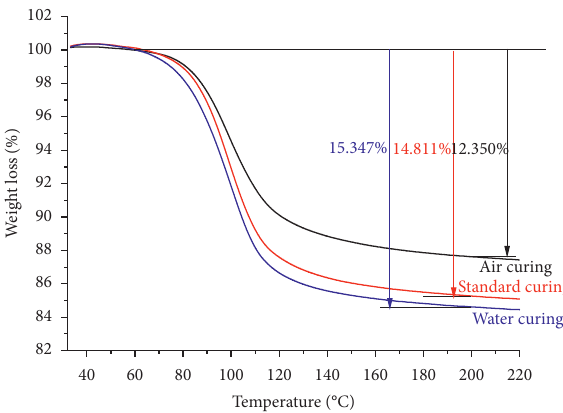
Figure 6: TG curves of MPC with the M / P ratio of 3:1 under various curing conditions after curing for 28d.